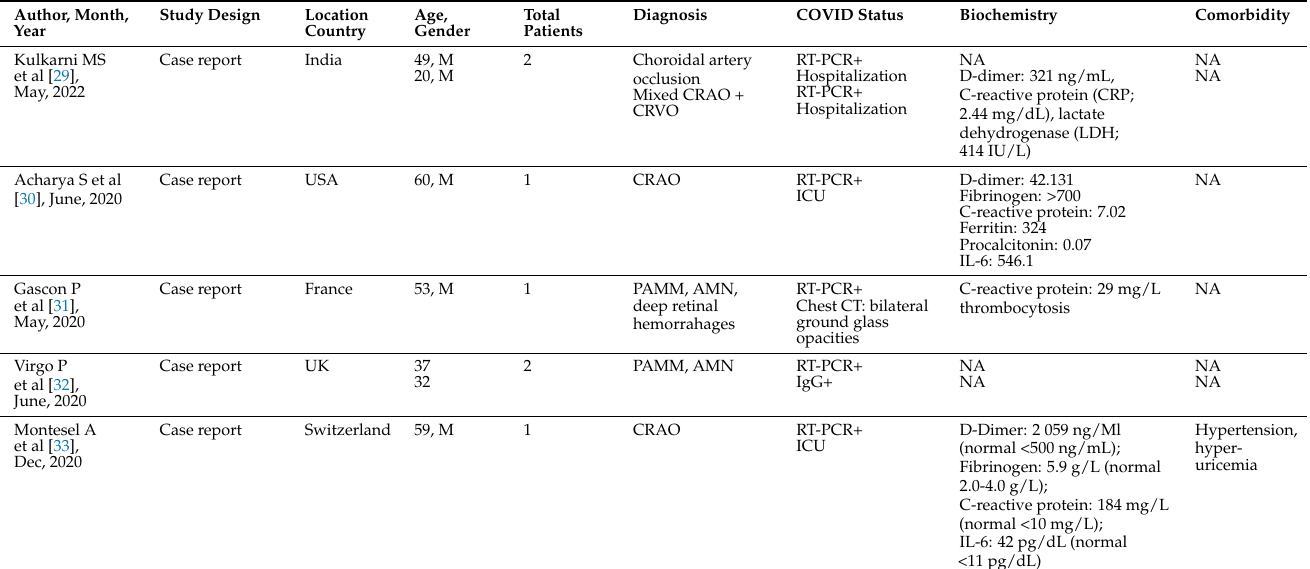
Table 3. Demographic and clinical manifestations of patients with retinal artery